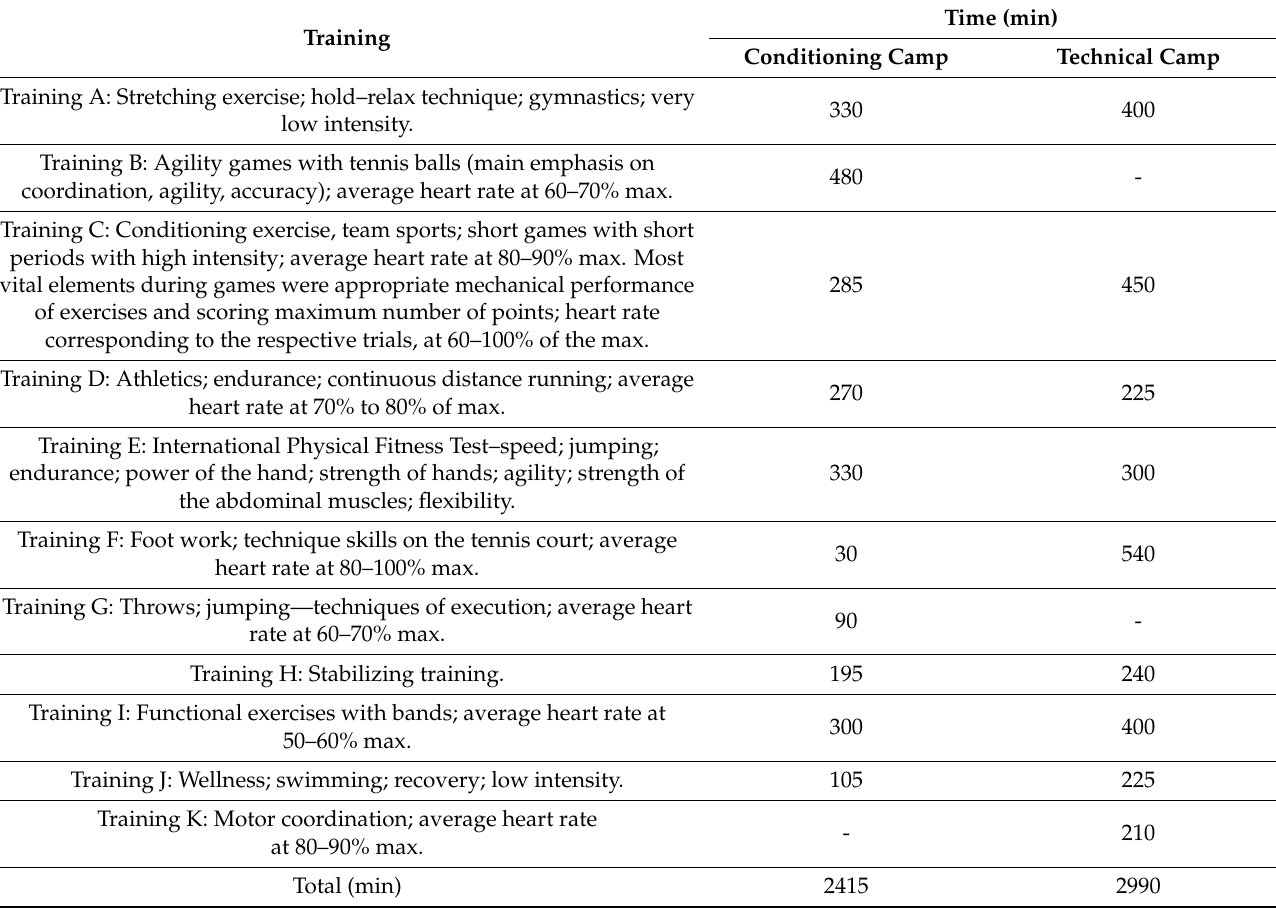
Table 2. Comparison of times for each type of training during two